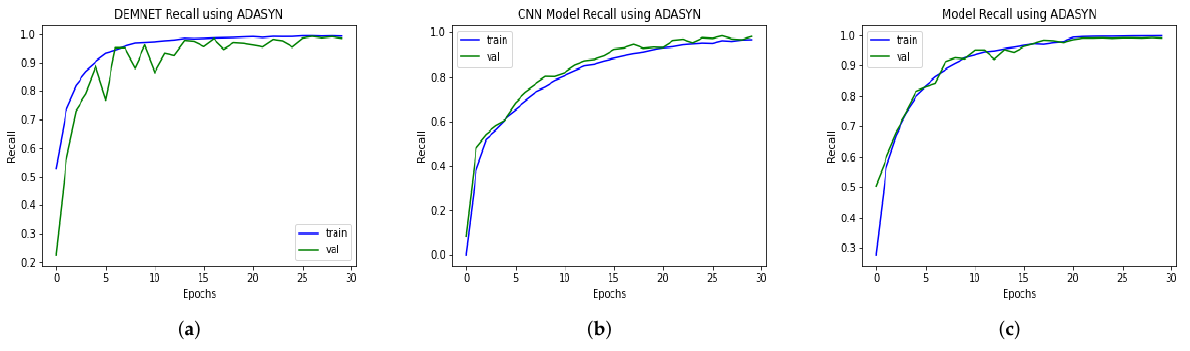
Figure 17. Recall Comparison of DEMNET, CNN Model, and DAD-Net using ADASYN. ( a ) DEM- NET; ( b ) CNN Model; ( c ) Proposed